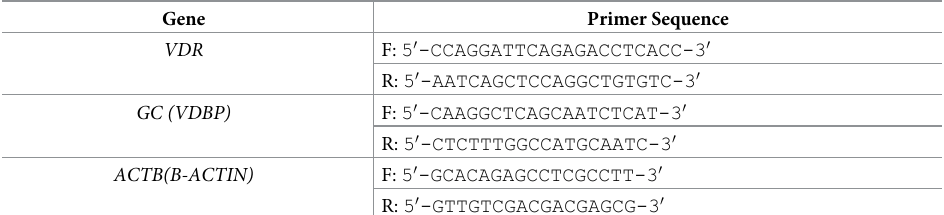
Table 1. Designed primers for VDR and GC genes. ACTB gene was used for internal